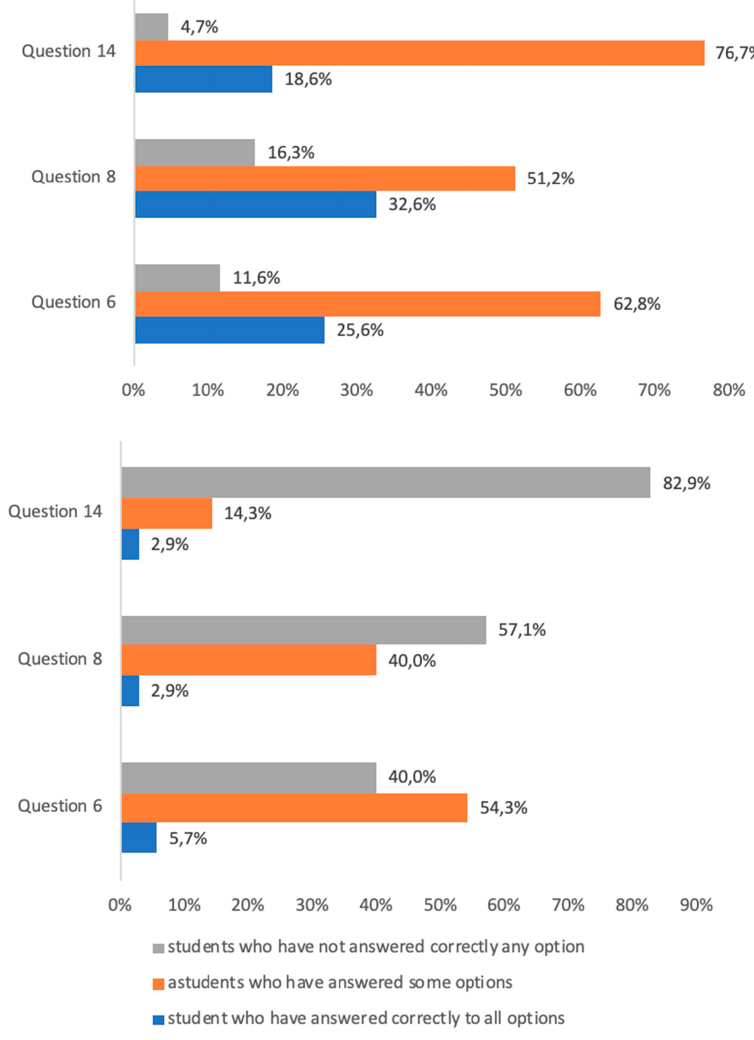
Figure 6. Results of the percentages of responses of students of the experimental ( top ) and control ( bottom ) groups in questions 6, 8, and 14.